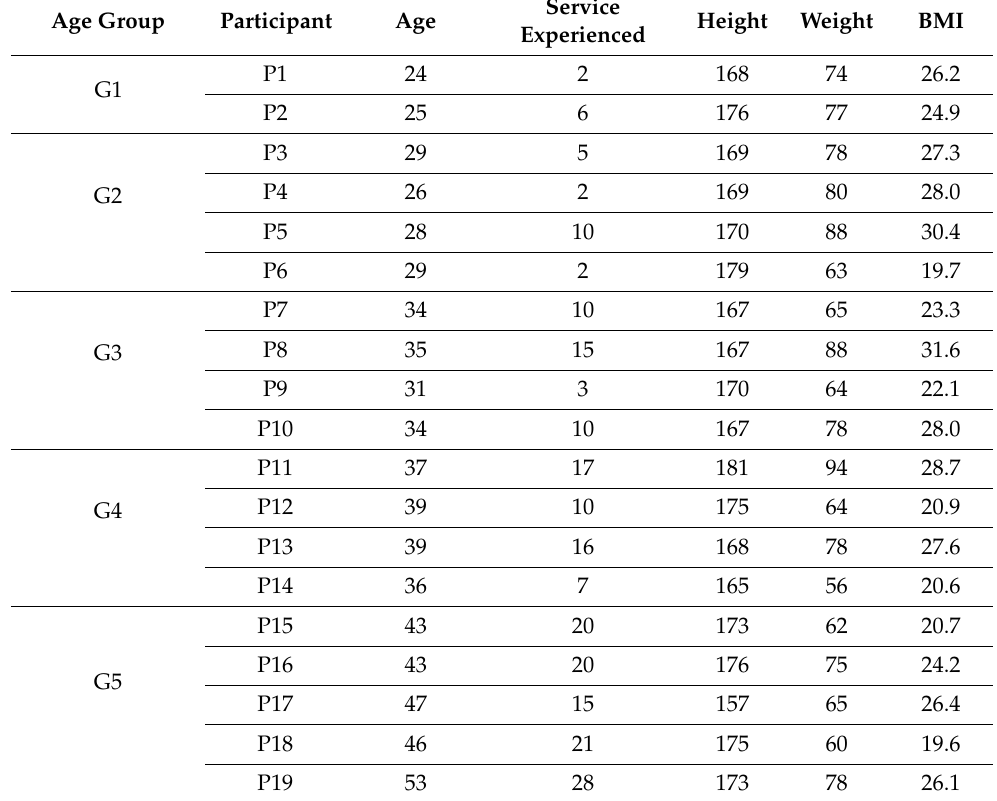
Table 1. FFs demographic